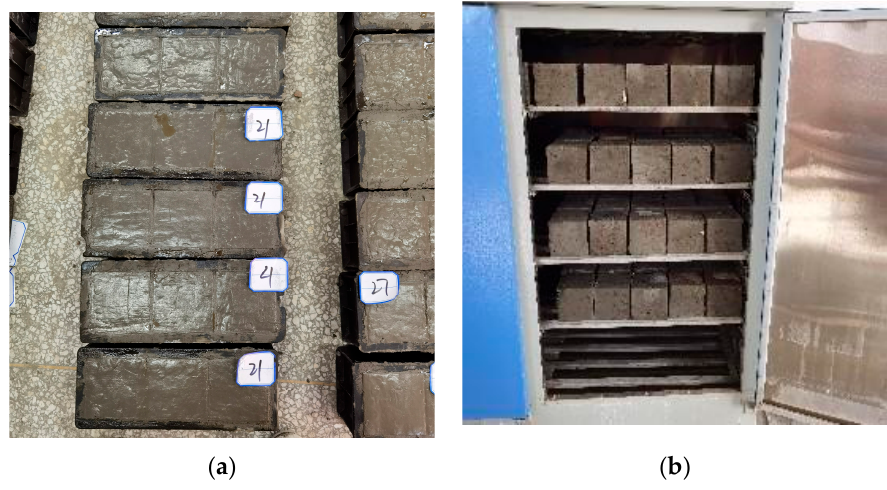
Figure 3. The specimens’ preparation and curing: ( a ) specimen preparation; ( b ) specimen curing.